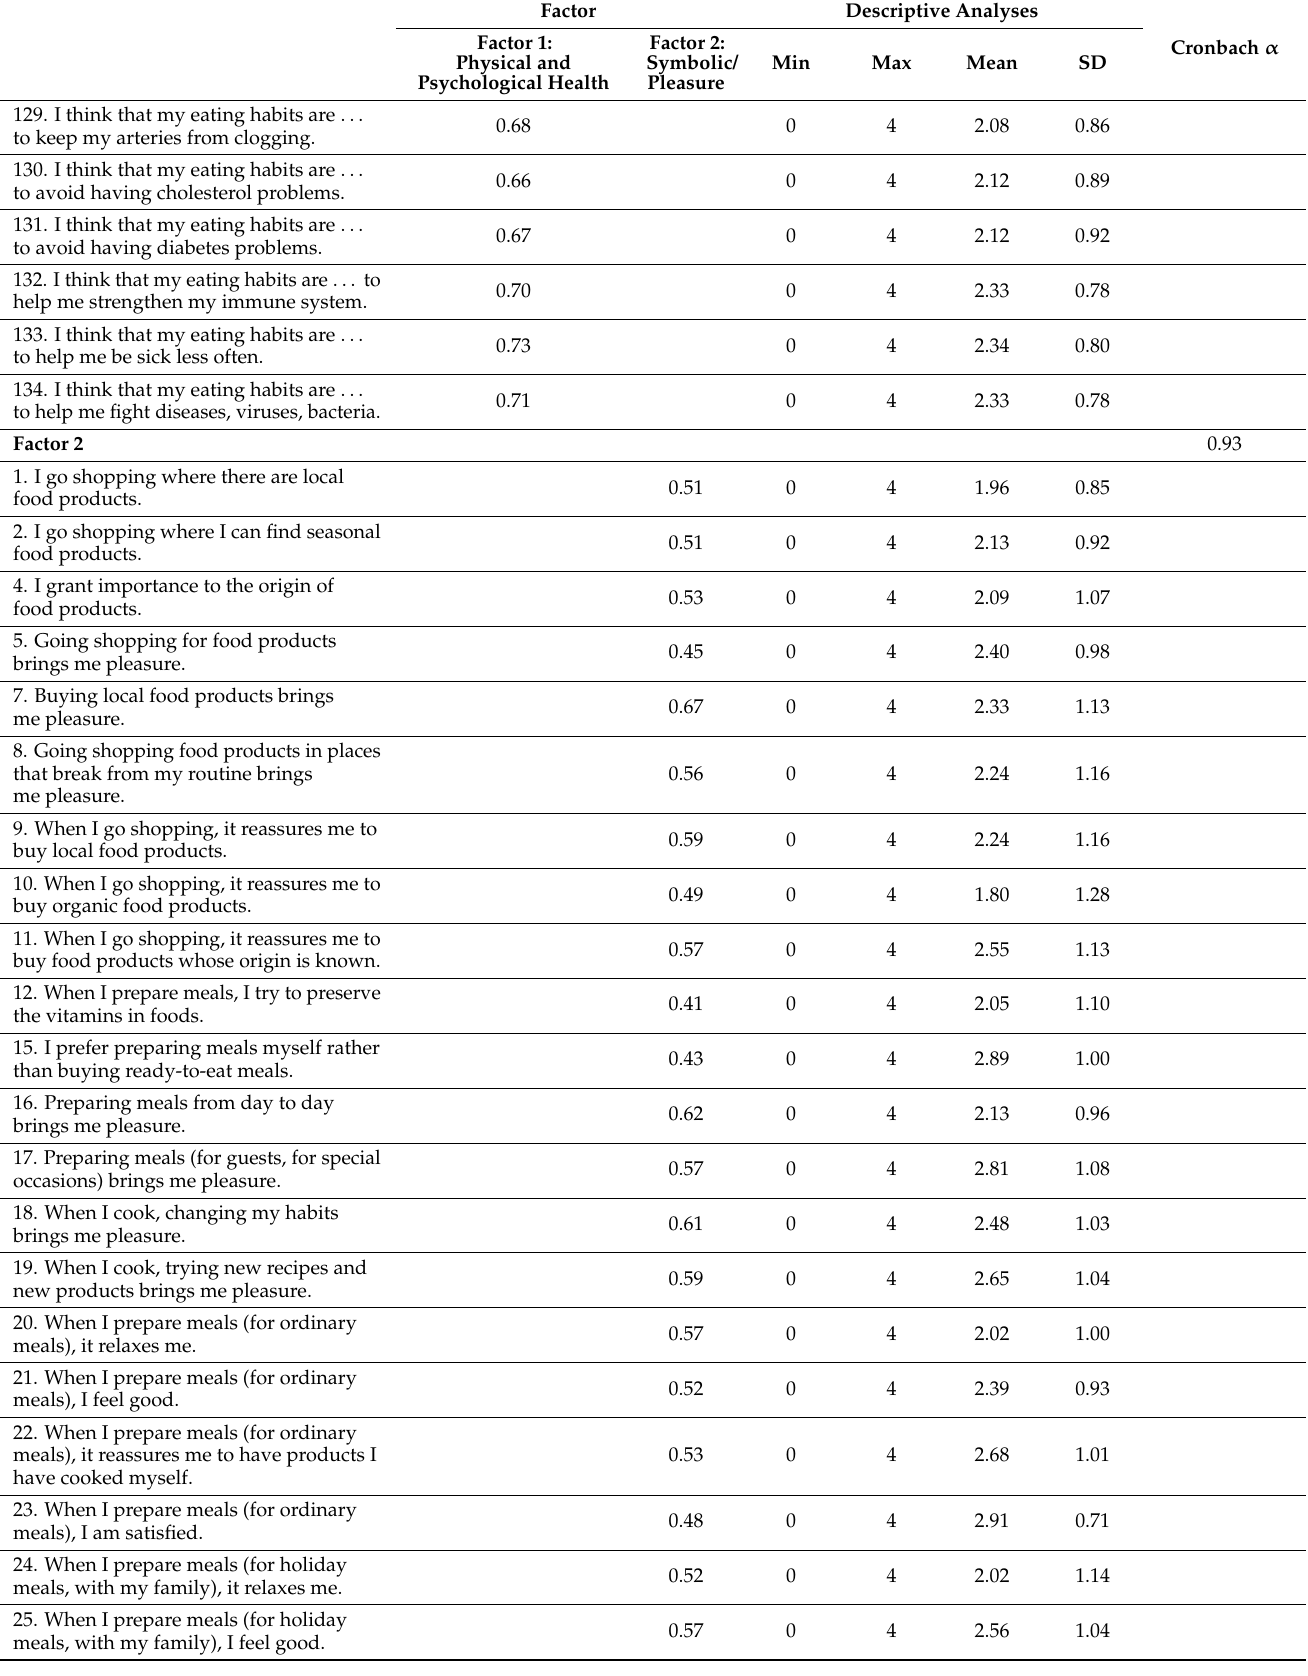
Factor Descriptive Analyses